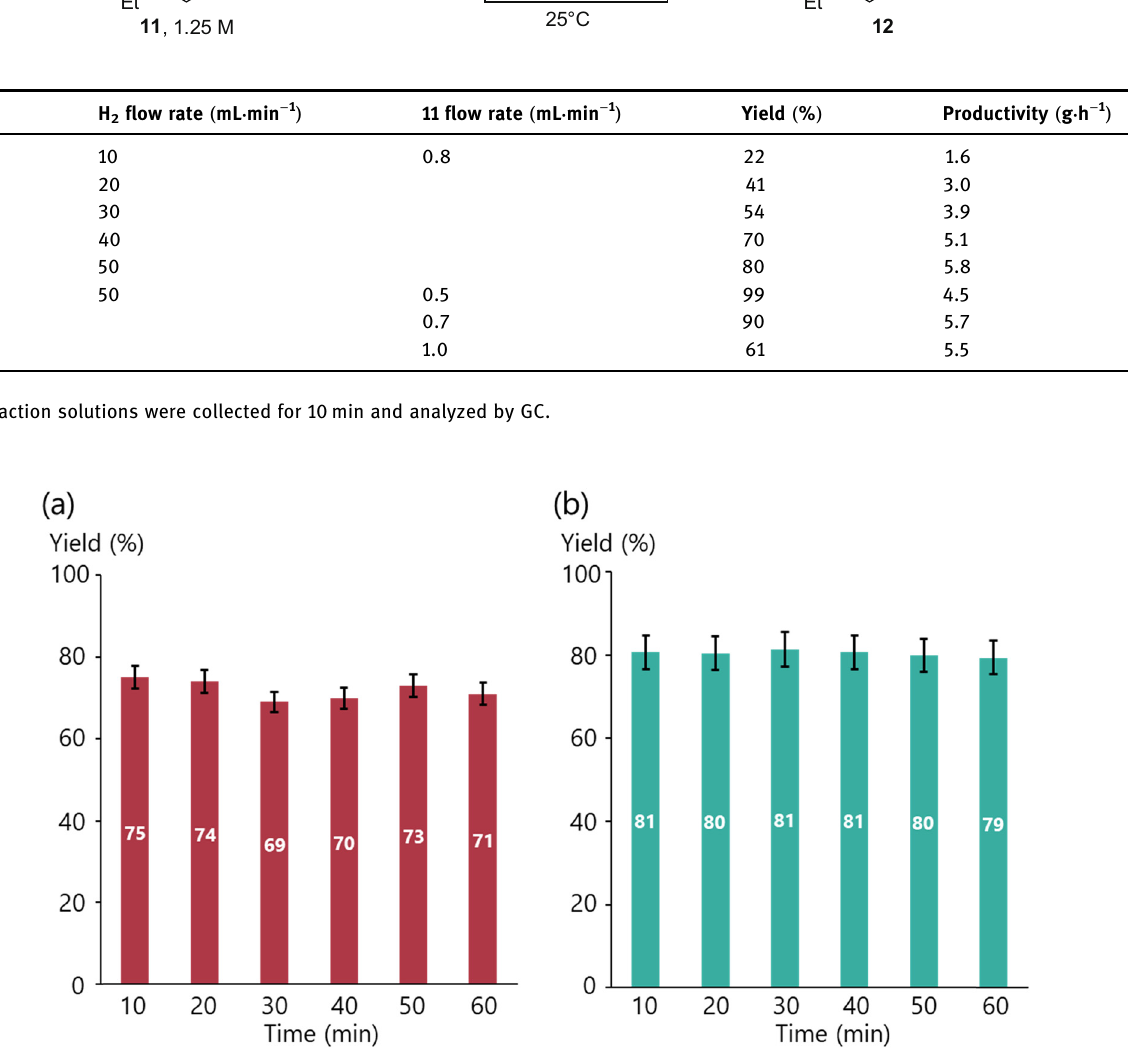
Figure 2: Long time operation for the fl ow reactions: ( a ) Stille cross - coupling and ( b ) hydrogenation. Error bars indicate the standard deviation of the